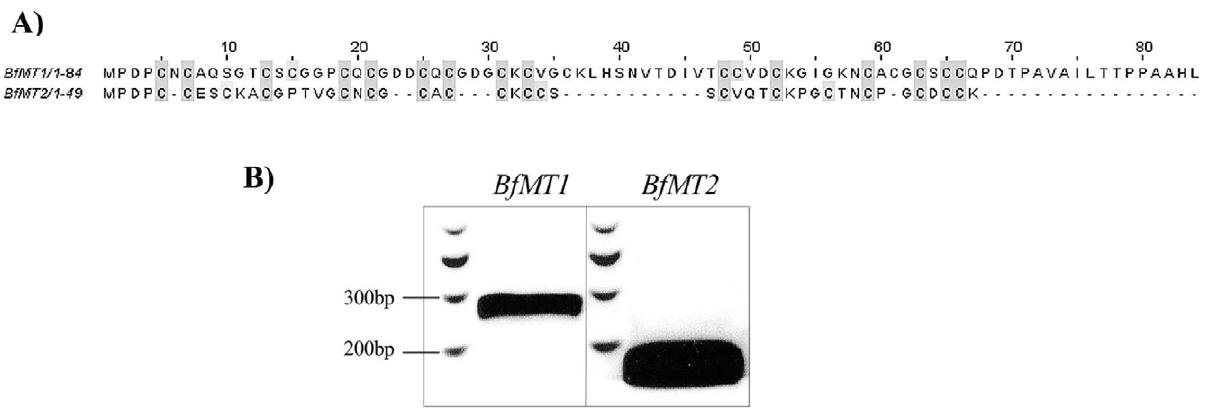
Figure 1. Protein sequences deduced of both identified Amphioxus metallothionein genes, which are patently transcribed in adult organisms. ( A ) Aligned protein sequences of the two identified amphioxus MTs, BfMT1 and BfMT2, in silico translated from the rbfeg037o01 and bfne062f22 cDNA clones, respectively. Cysteine residues are highlighted in gray. Alignment was performed using the T-Coffee software. ( B ) RT-PCR amplification of BfMT1 and BfMT2 cDNA using adult B. lanceolatum total mRNA as a template. Both band sizes corresponded to that expected for the respective coding sequences (255 bp for BfMT1 and 150 bp for BfMT2). The amplified cDNAs were cloned, and their sequences were verified as exact matches with respect to the B. floridae library cDNA